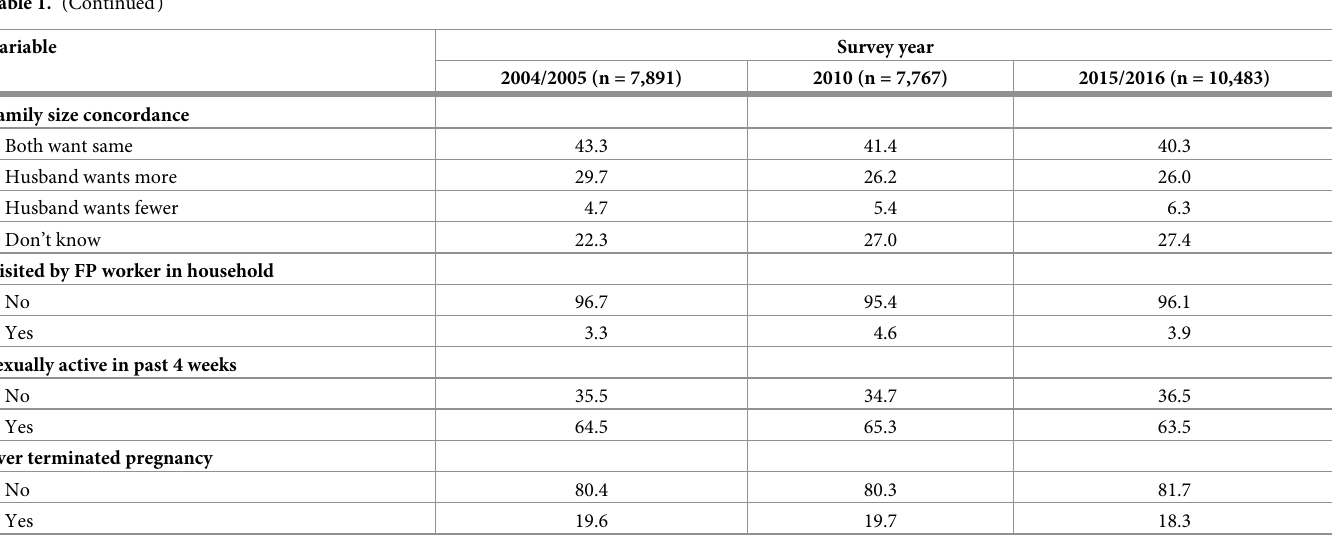
in rural areas occurred during phase 1 at 11.2 percentage point increase compared with a 4.0 percentage point increase during phase 2. Factors associated with changes in modern contraceptive use The results of the Poisson decomposition regression analysis for factors associated with changes in modern contraceptive use between 2004/2005 and 2015/2016 are presented in Table 3. We found that 12.5% of the overall percentage change in modern contraceptive use was attributable to the difference in characteristics ( compositional changes ). These included partner’s education levels, wealth categories, exposure to family planning messages in the media as well as recent sexual activity. An increase in the proportion of women whose partners attained secondary level of education and above (Table 1) resulted in a significant positive con- tribution on modern contraceptive use between 2004/2005 and 2015/2016 (4.17%, p-value: 0.001).